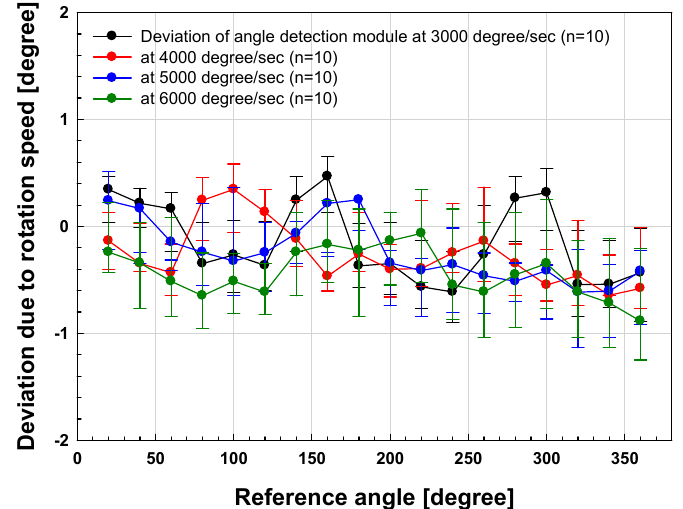
Figure 10. Deviation results of the proposed angle sensor module due to rotation speed.